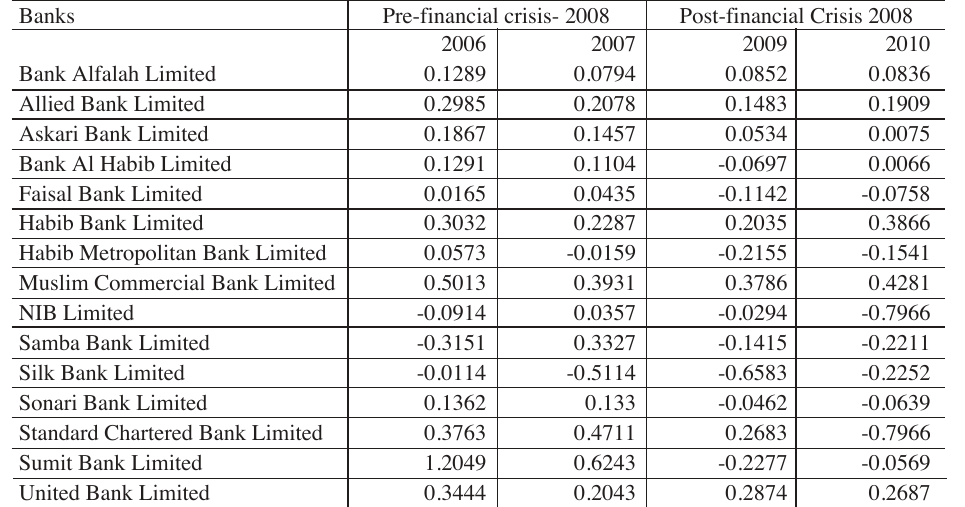
Altman's Z-Score